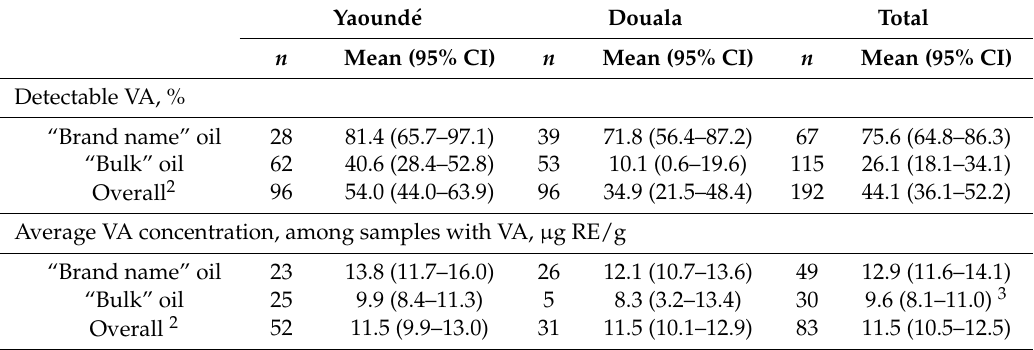
Table 2. Vitamin A content of refined oil samples collected from households in Yaound é and Douala 1 .